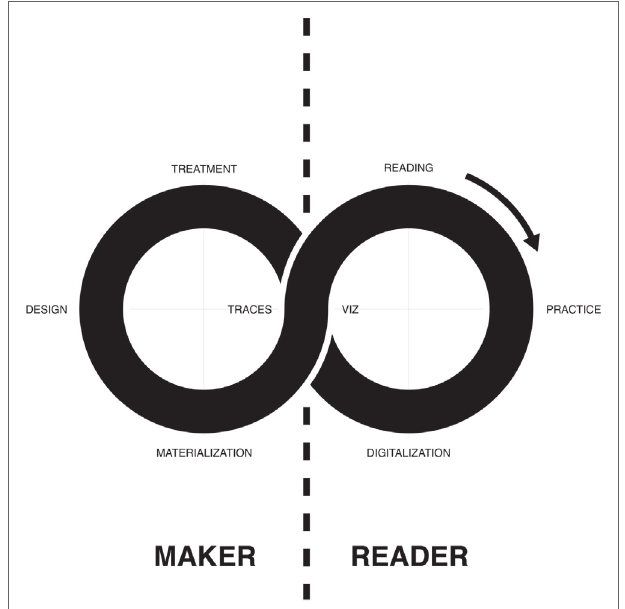
FigUre 6 | The cycle of the visualization combines mapmaker and